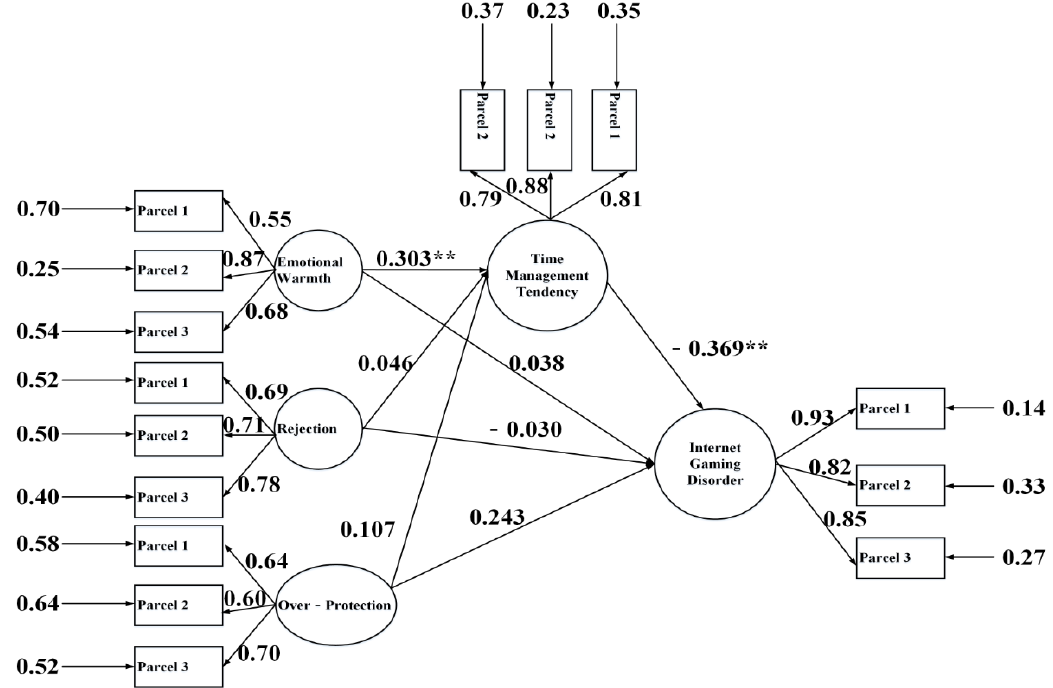
Figure 3. Mothers’ model for mediation analysis. Note: ** p < 0.01.